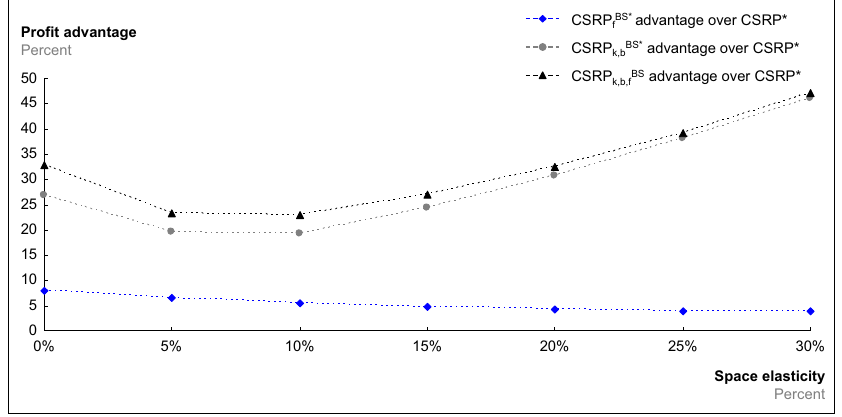
Fig. 3 Relative profit advantage of integrated and partial optimization models over status quo